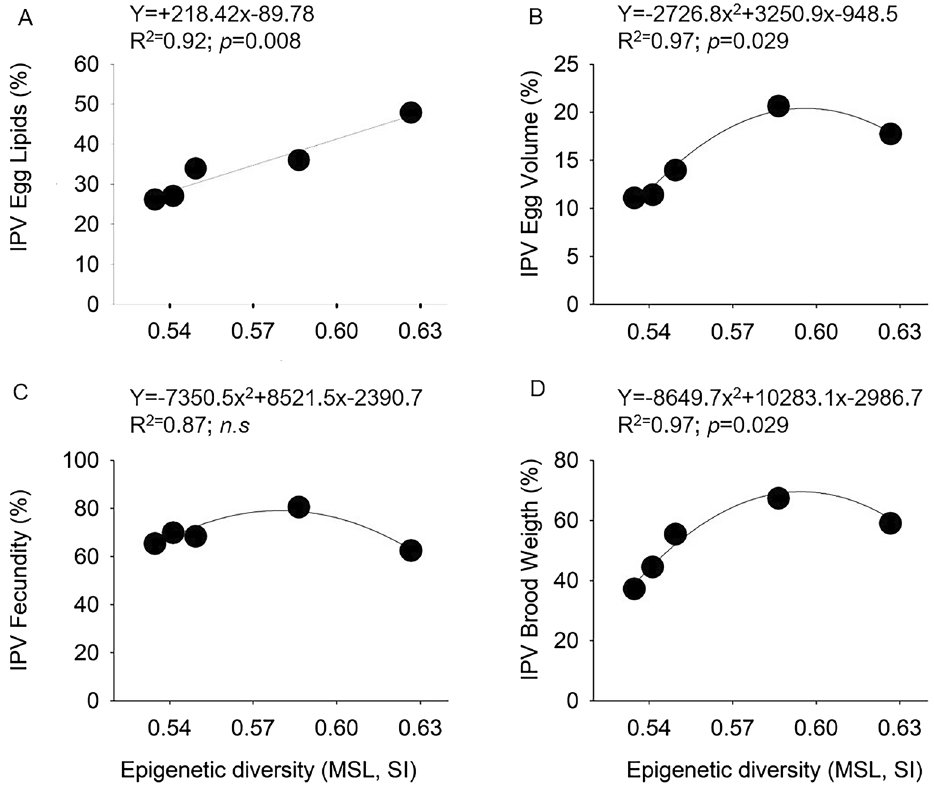
Figure 6. Results of OLS regressions between Interpopulation Phenotypic Variability (IPV) of ( A ) egg lipids and epigenetic diversity, ( B ) egg volume and epigenetic diversity, ( C ) fecundity and epigenetic diversity, ( D ) Brood Dry Weight and epigenetic diversity. The equation of the best fitting model is shown on top of each graph along with the proportion of variance explained (R 2 ) and the p- values for the significance level (α = 0.05). n.s., no significant; IPV, interpopulation Variability Index; SI, Shannon Index; MSL, Methylation Sensitive